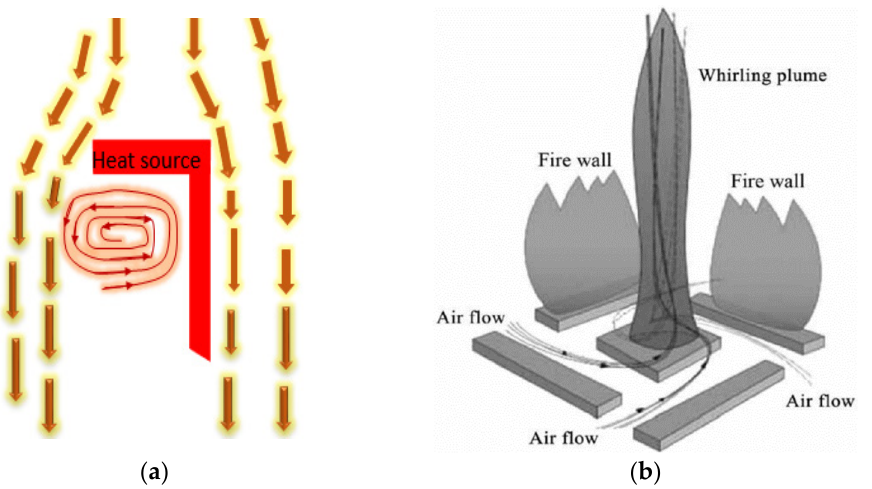
Figure 2. ( a ) Schematic of fire whirl formation for an L-shaped heat source in a crossflow wind. View is from above [17]. ( b ) Schematic showing one configuration that can cause a multiple interacting plume type fire whirl [17].